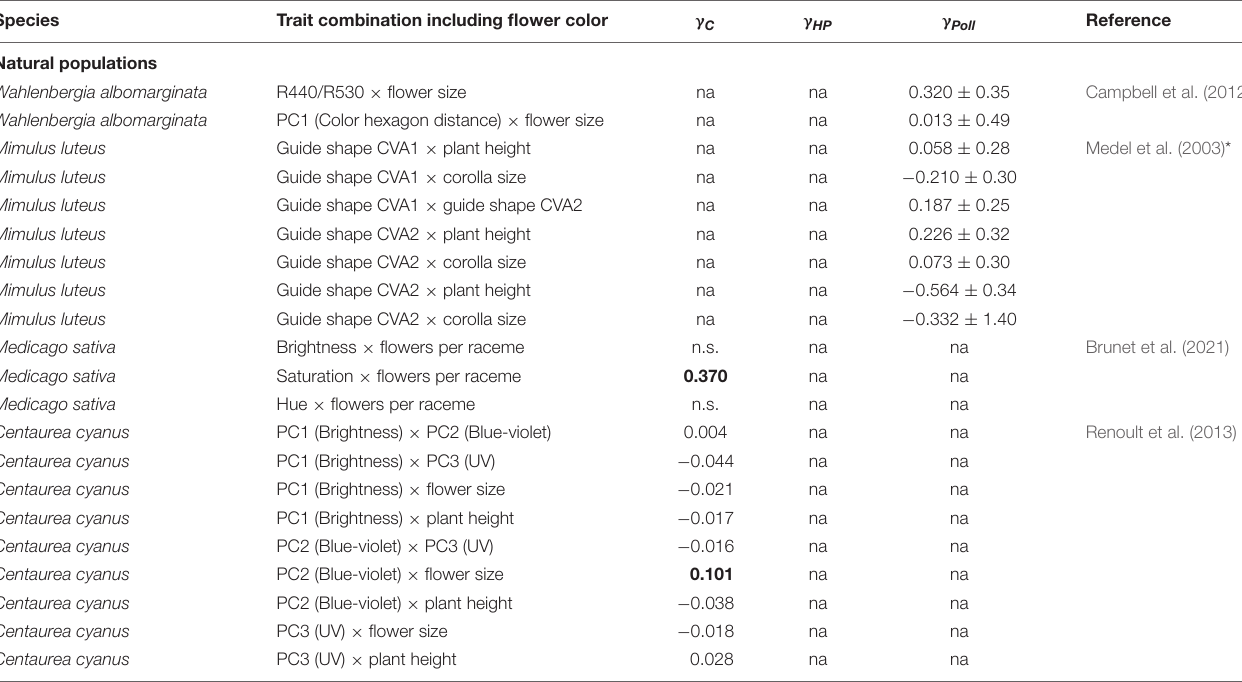
TABLE 4 | Summary of correlational selection gradients ( ± SE) extracted from the literature for net selection ( γ C ), non-pollinator-mediated selection ( γ HP ) and pollinator-mediated selection ((cid:49) γ Poll ) on flower color estimated in natural plant populations and experimental